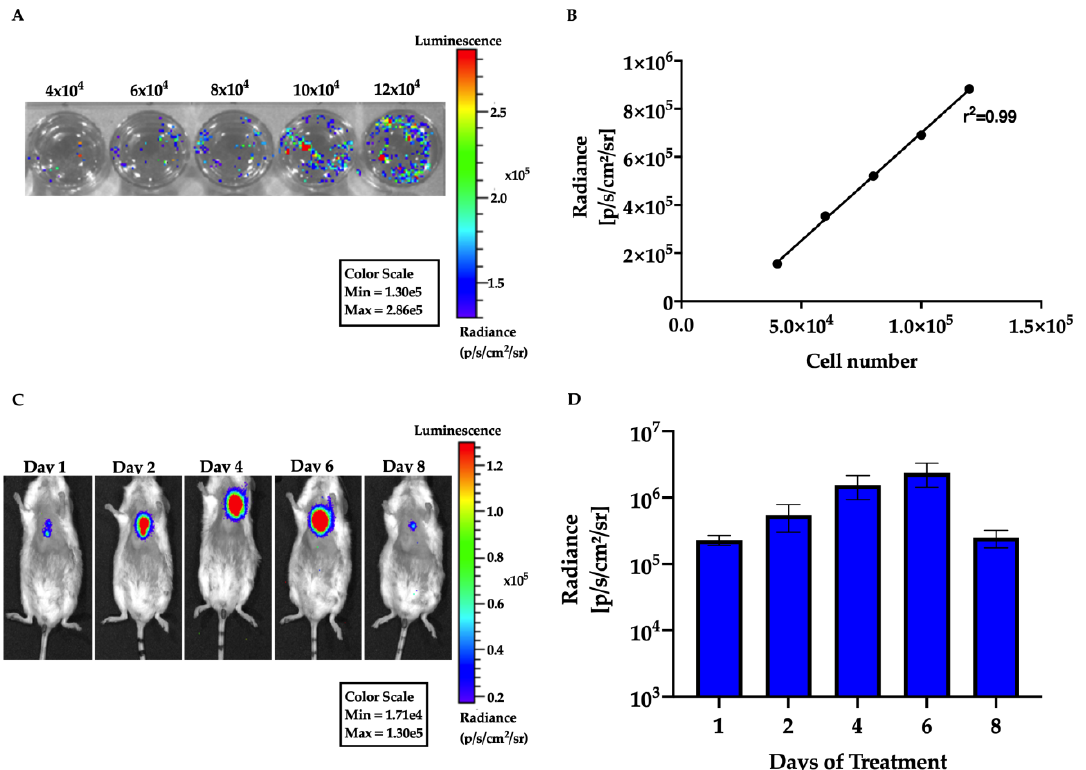
Figure 6. CM-mESC tracking by bioluminescence. ( A ) Assessment of luminescent signal intensity in CM-mESC transduced with the luciferase 2 gene in vitro. The numbers shown above the wells indicate the number of cells. ( B ) The signal linearly increased with cell numbers ( r 2 = 0.99). ( C ) in vivo cell tracking shows a luminescent signal on the precordial region in Chagasic mice ( n = 7). Luminescence was detected for up to 8 days after injection. ( D ) Quantification of the luminescent signal showed a progressive decrease in radiance units with time. The data is plotted on a log scale. CM-mESC—cardiomyocytes derived from mouse embryonic stem cells.